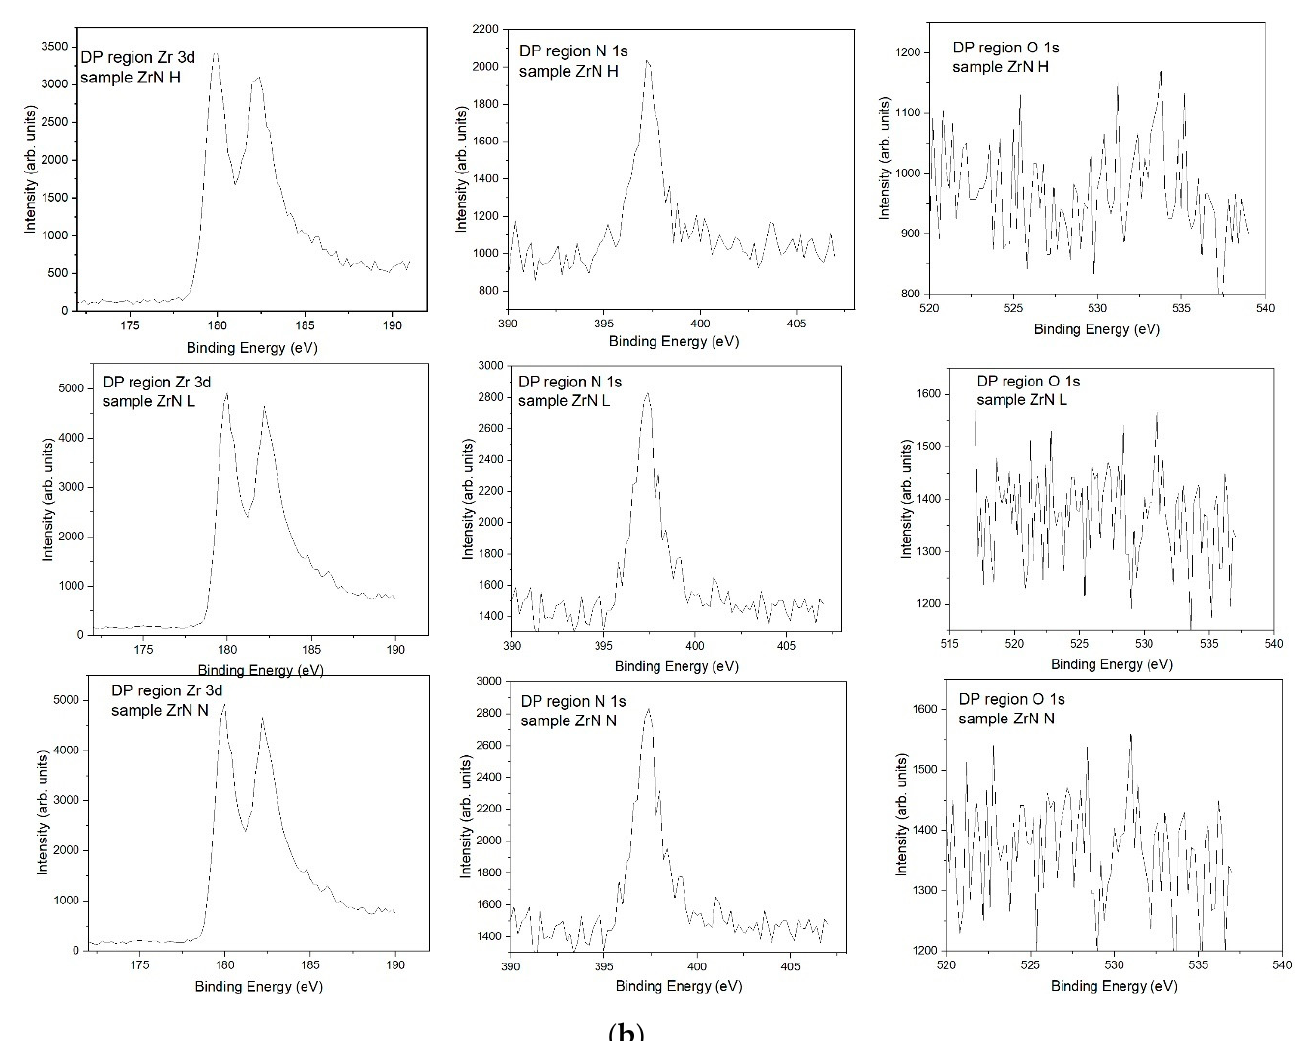
Figure 9. ( a ): Surface high-resolution spectra of Zr 3d, N 1s and O1s for samples ZrN H, L, N. ( b ): In-depth acquisitions of high-resolution spectra of Zr 3d, N 1s and O1s for samples ZrN H, L, N after two sputter-cycles (labelled as DP region).